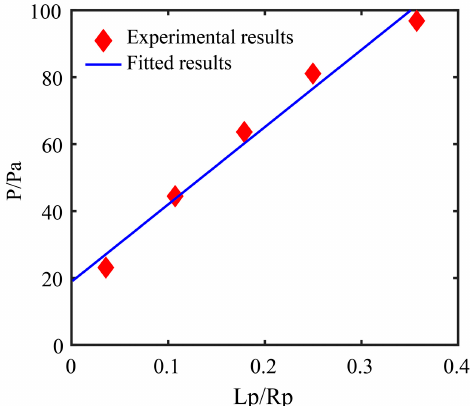
Figure 13. The relationship between the aspiration pressure and the elongation of the zona pellucida (ZP) when its Young’s modulus is detected as 22.80 kPa.